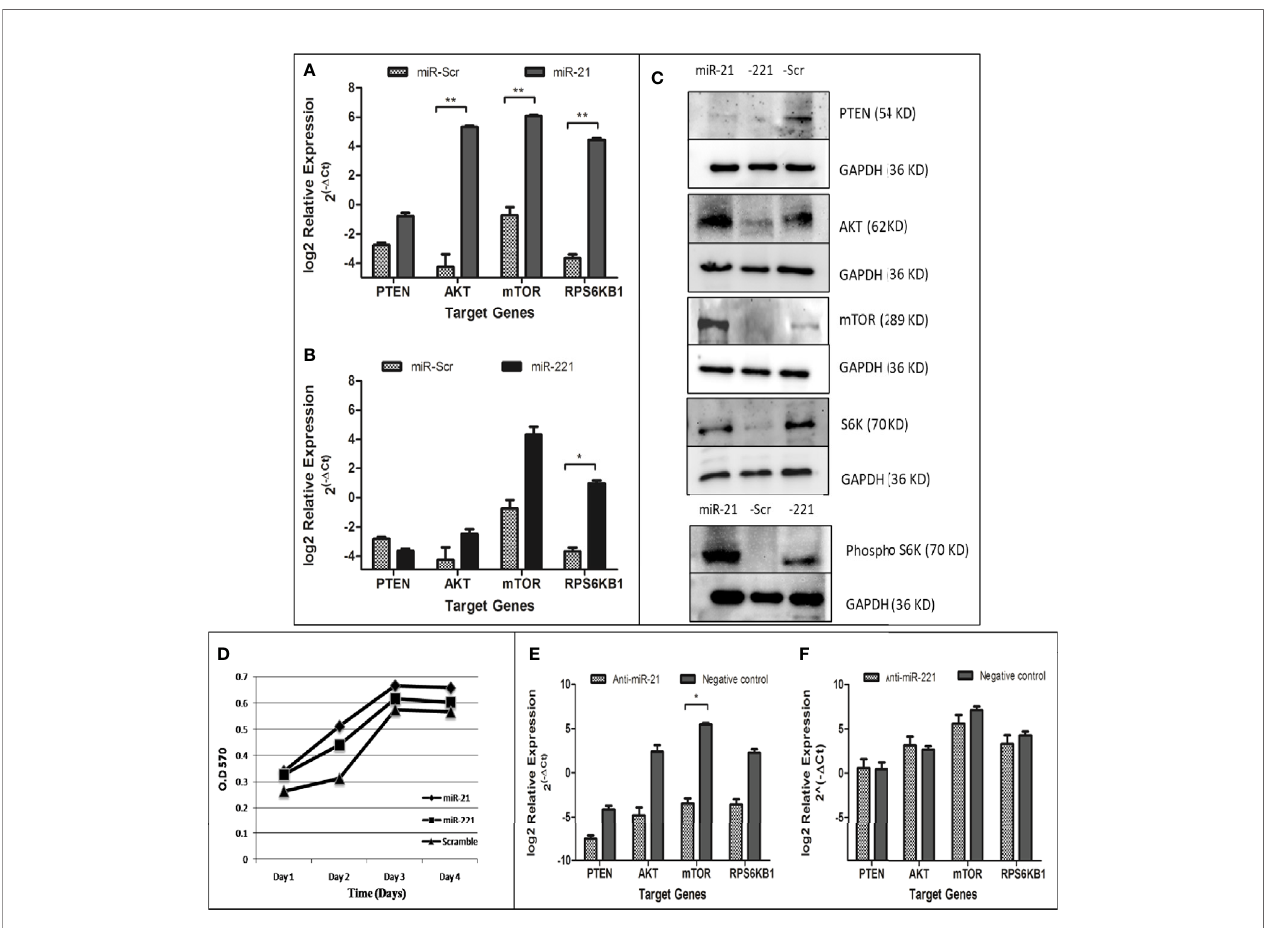
FIGURE 8 | Functional evaluation of PTEN/AKT/mTOR pathway activation in oncomiR overexpressing cell lines. Relative expression of mTOR pathway associated genes (PTEN, AKT, mTOR, and RPS6KB1) in miR-21 (A) and miR-221 (B) cell line as compared to miR-Scr cell line following normalization with beta-actin. Immunoblot of PTEN, AKT, mTOR, total/phosphorylated p70S6K, and GAPDH in miR-21, -221, and Scr overexpressing cell line (C) . Effect of oncomiR on cell proliferation was assessed by MTT assay (D) . Effect of antimiR-21 (E) and antimir-221 (F) on mTOR pathway was compared to negative antimiR control for relative gene expression of PTEN, AKT, mTOR, and RPS6KB1 by real-time PCR. (*P ≤ 0.05), (**P ≤ ( Figure 7C ) and -miR-221 ( Figure 7D ) stable cell lines as compared to miR-Scr cell line.